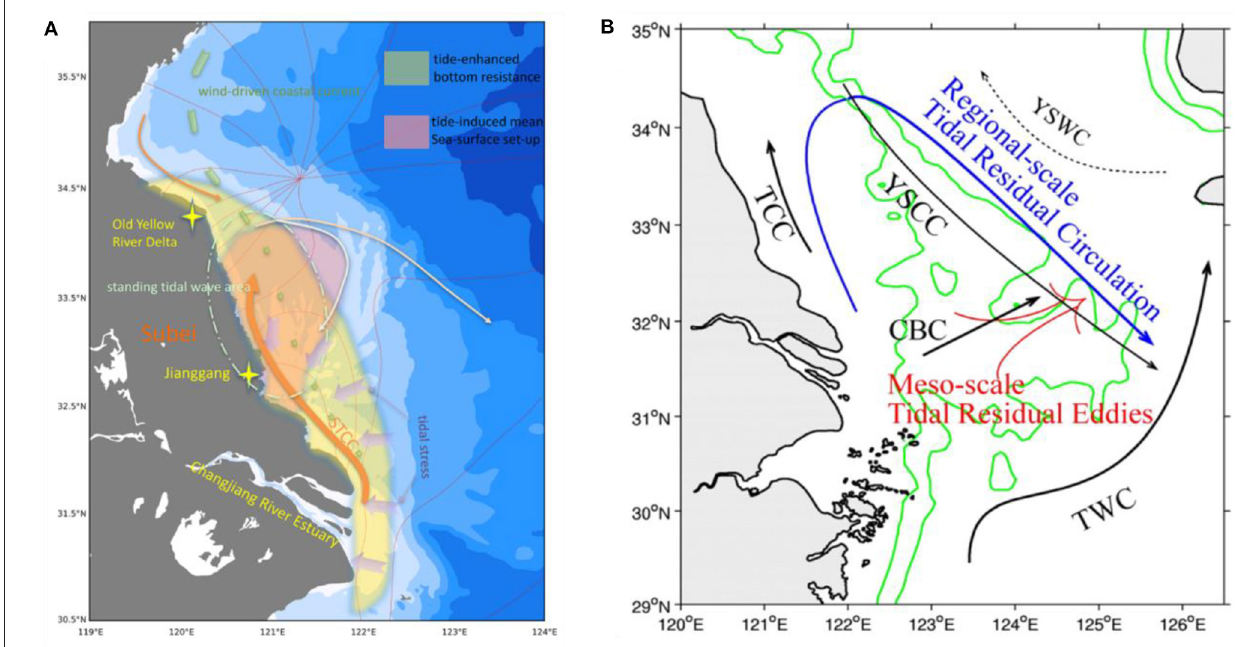
FIGURE 5 | (A) Sketch map of residual transport over the Subei Shoal and its controlling mechanisms by the Subei tide-induced coastal current (STCC), which is raised from tidal stress (pink arrows) in the coastal seas to the north of Changjiang Estuary. The thin red lines indicate co-phase lines for the M 2 tide with an interval of 30 ◦ . The wind driven coastal current in winter is indicated by the green arrows, and the circulations over the eastern flank of Subei Shoal is indicated by the yellow thin lines. This figure is adapted from Wu et al. (2018a). (B) Tidal residual current and mean flow over the Subei Shoal. Meso-scale tidal residual eddies (red arrow) and regional-scale tidal residual circulation (blue arrow) show the patterns of the tidal residual current across and around the Subei Shoal. The structure of mean flows (five black arrows) is composed by Taiwan Warm Current (TWC), YSCC, Changjiang Bank Current (CBC), Tidal-induced Coastal Current (TCC), and YSWC. This figure is adapted from Xuan et al.